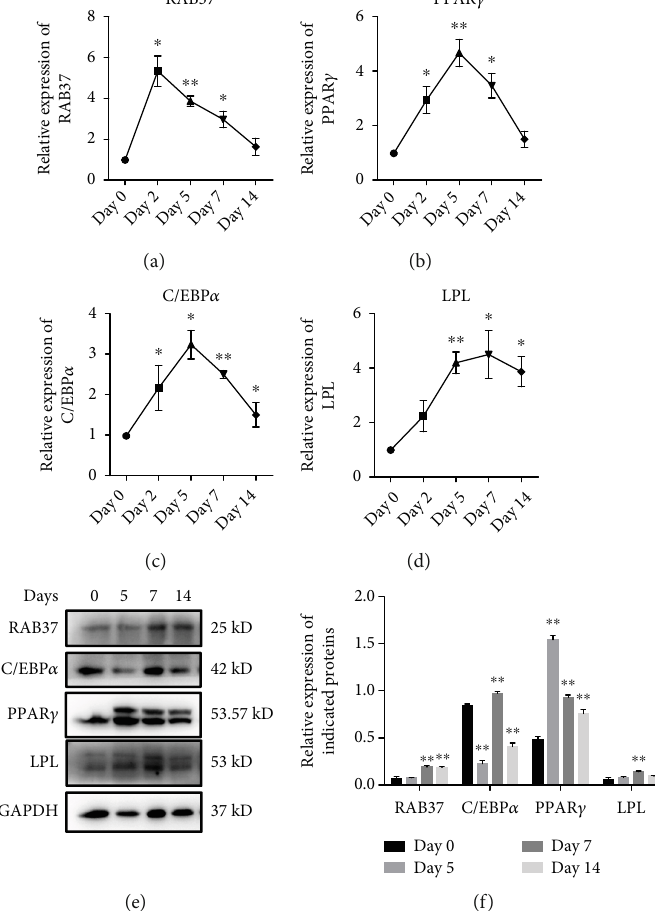
Figure 1: The expression of RAB37 fl uctuated during adipogenic di ff erentiation of ADSCs. Adipogenic induction of hADSCs was carried out over a period of 14 days. The expression of RAB37 (a) and adipogenesis-related genes, PPAR γ (b), C/EBP α (c), and LPL (d), was examined by qRT-PCR and western blotting (e) at the indicated time points. (f) Densitometry analysis of the western blots, n = 3 . ∗ p < 0 : 05 ; ∗∗ p < 0 : 01